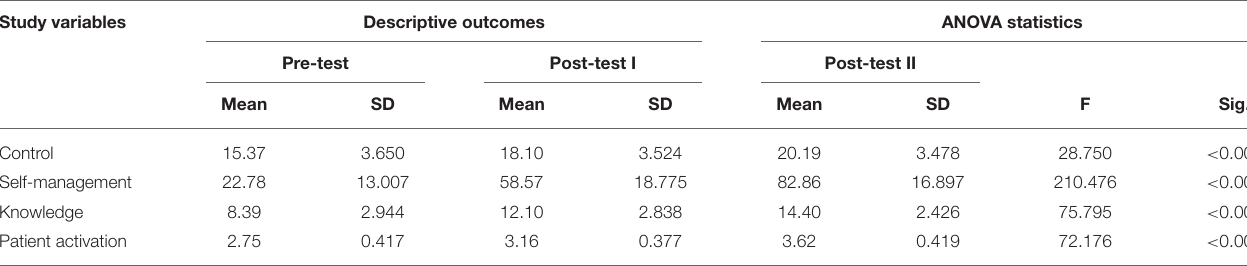
TABLE 3 | Change within intervention group across different program stages.